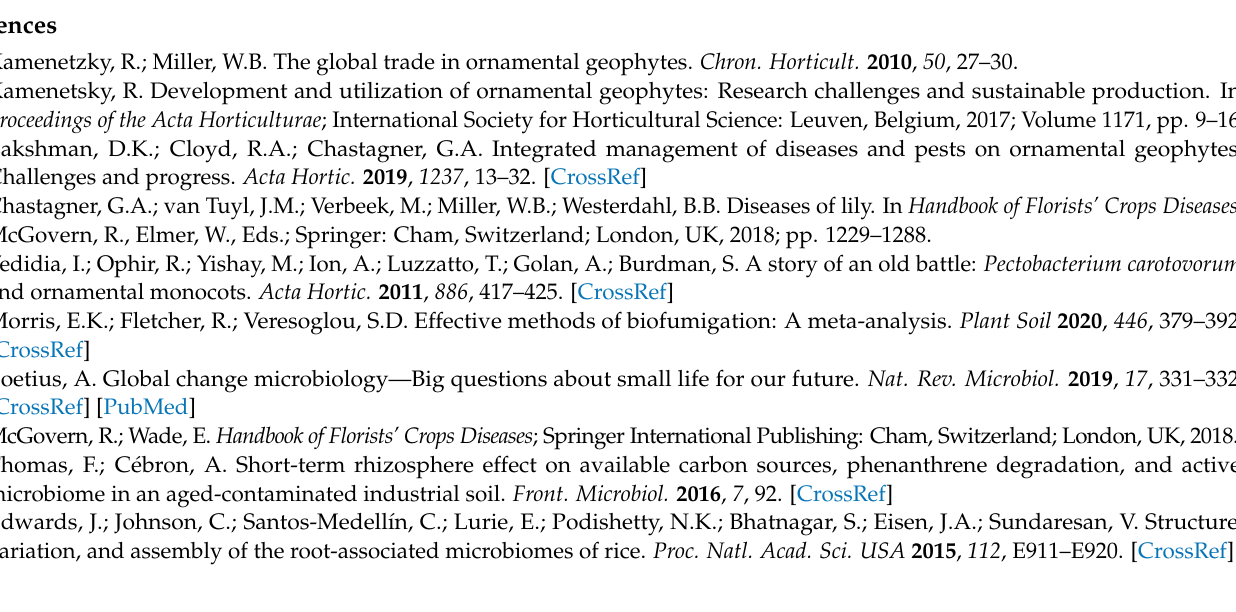
Supplementary Materials: Supplementary materials can be found at https://www.mdpi.com/article/ 10.3390/microorganisms9081785/s1. Figure S1: Taxonomic classification (at the class level) of the mi- Figure S2: Microbial population dynamics by growing medium and plant species. Figure S3: Principal-coordinate analysis (PCoA) plots of weighted Unifrac distance metrics of bacterial popula- tions surrounapding the roots of Ornithogalum dubium and Zantedeschia aethiopica